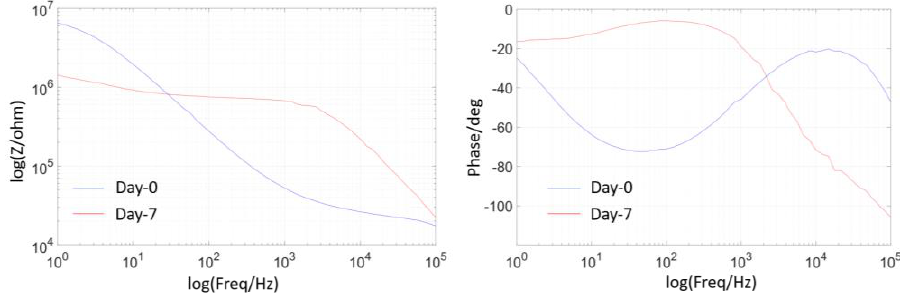
Figure 3. EIS plots of a 1 μm PA coated, open tip sample soaked in PBS + 30 mM H 2 O 2 solution at Day-0 to